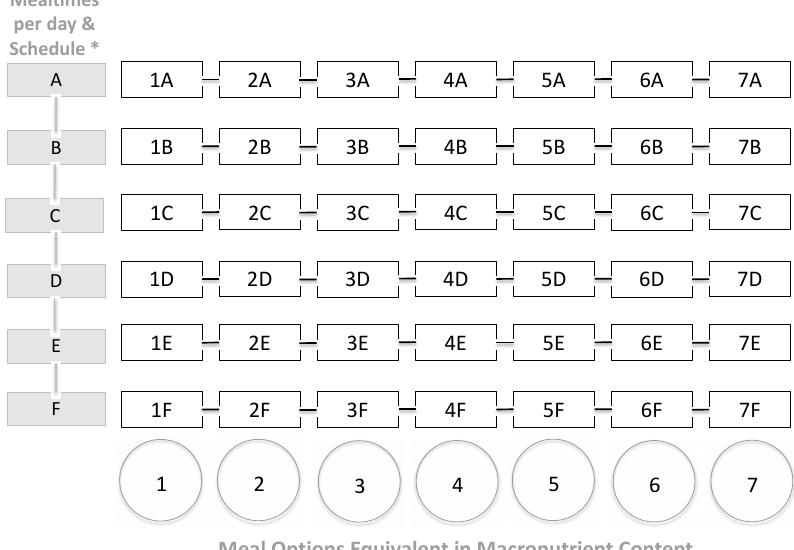
Figure 2. Individualized macronutrient meal-equivalent menu model. *The health care professional/registered dietitian nutritionist coordinated with the patient will set the mealtimes and the schedule for the MEM.